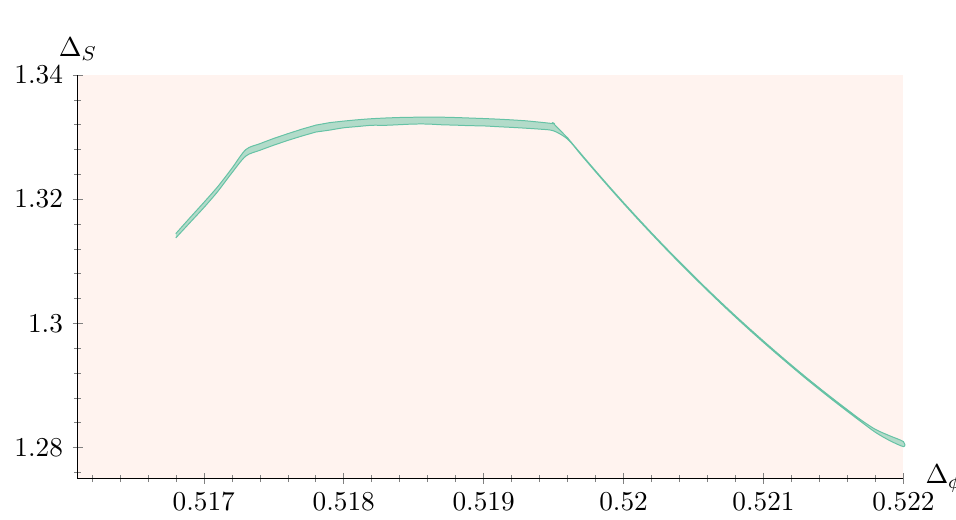
Figure 4: In this plot we assume, in addition to (S-1)–(S-4), that X (cid:48) has a dimension of 2.8 or higher. This extra assumption leads to the truncation of the allowed region on the